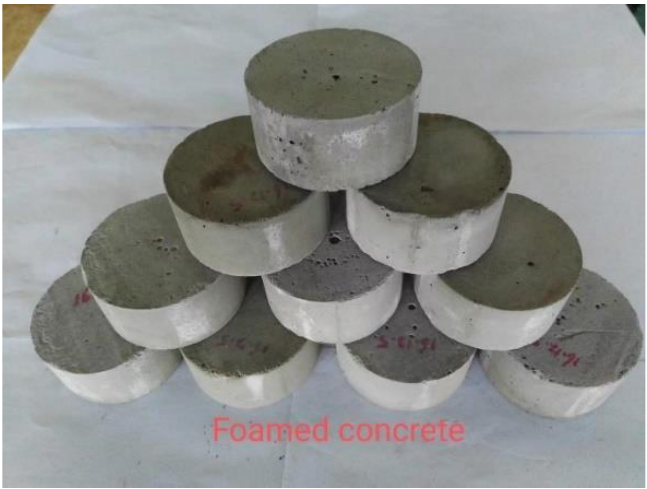
Figure 6. Foam concrete specimen.